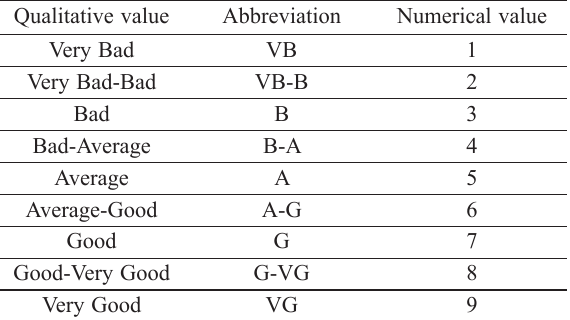
Table 2. Qualitative scale Qualitative value